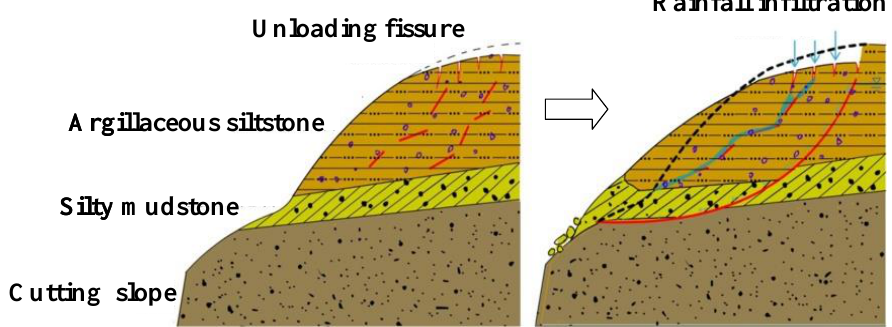
Figure 16. Schematic description of a global translational landslide in a red-bed slope in South China.